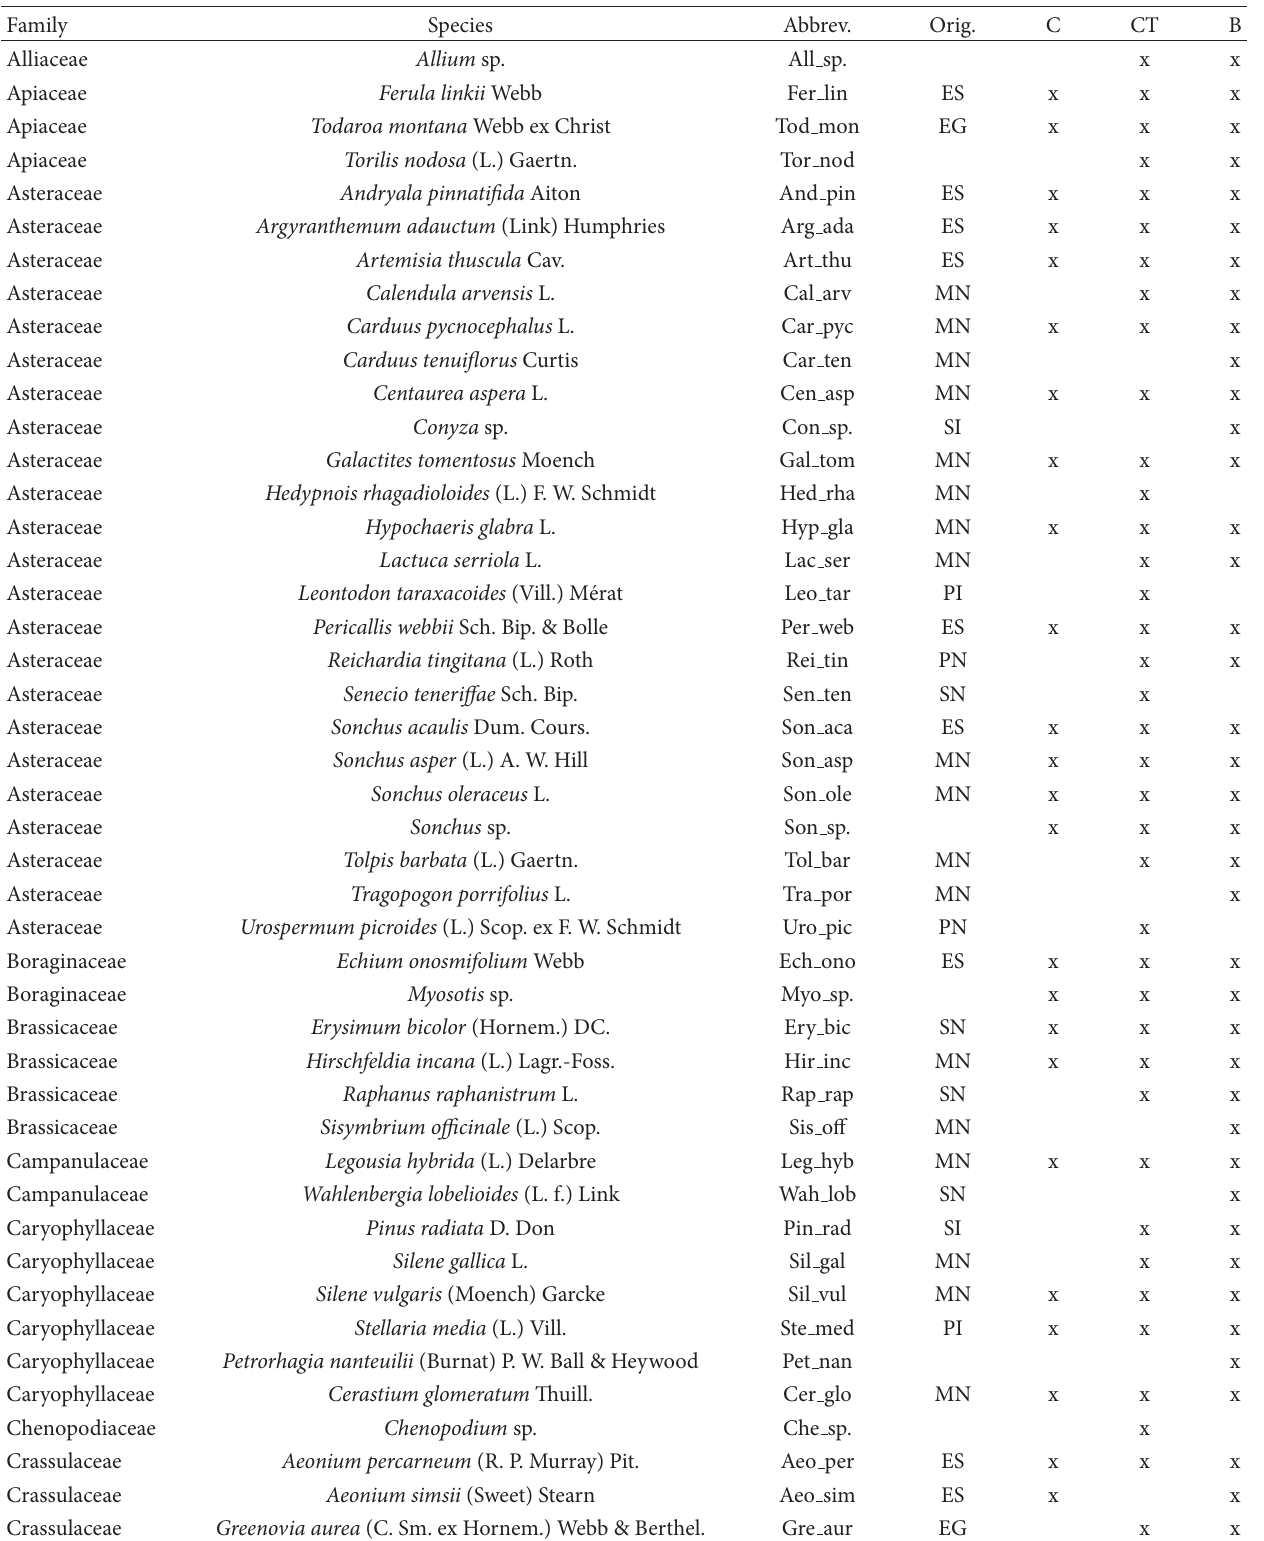
Table4:Plantspecies(107spp.)recordedduringtheresearchofthecuttingandburningeffectsonvegetationcompositionin